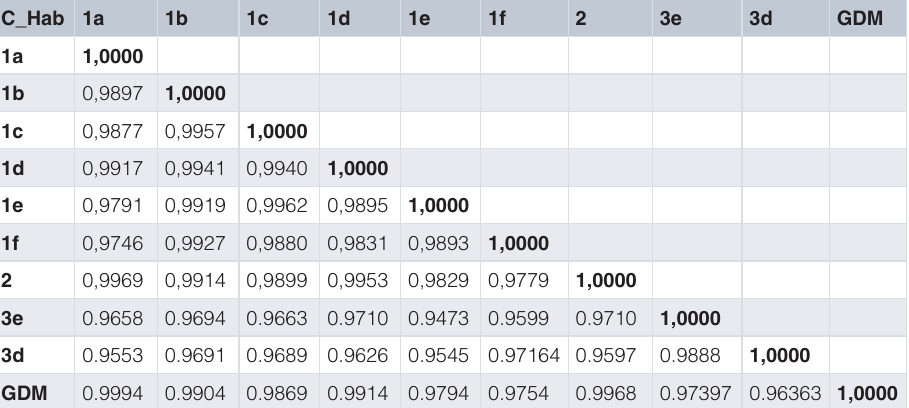
Table 5. Molecular quantum similarity indices using the Coulomb operator in Equation 12.